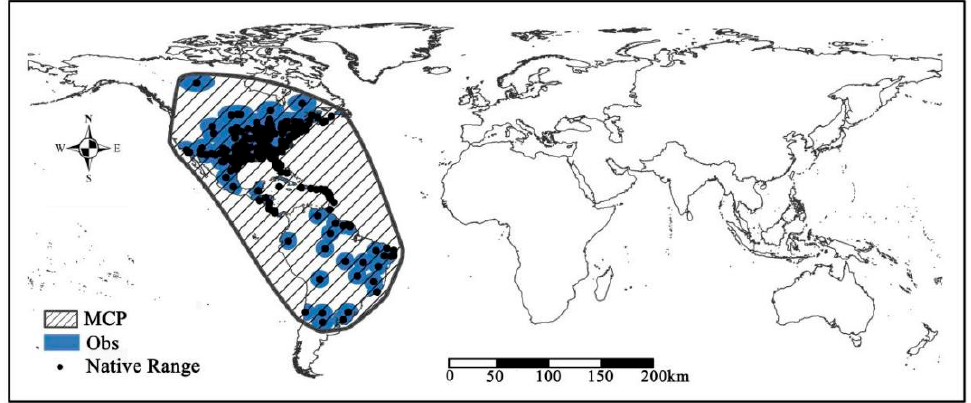
Figure 1. Geographic distribution of Spodoptera frugiperda in native range. The black dots represent the native points. MCP and Obs represent two different buffers to define the accessible areas used for niche modeling.